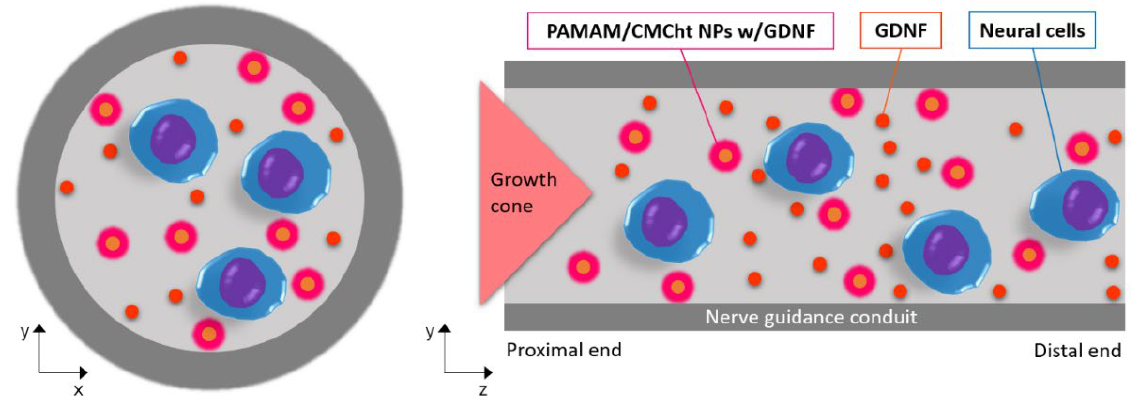
Figure 1. Illustration of NGC with the incorporation of CMCht/PAMAM NPs loaded with GDNF for GF release and improvement of